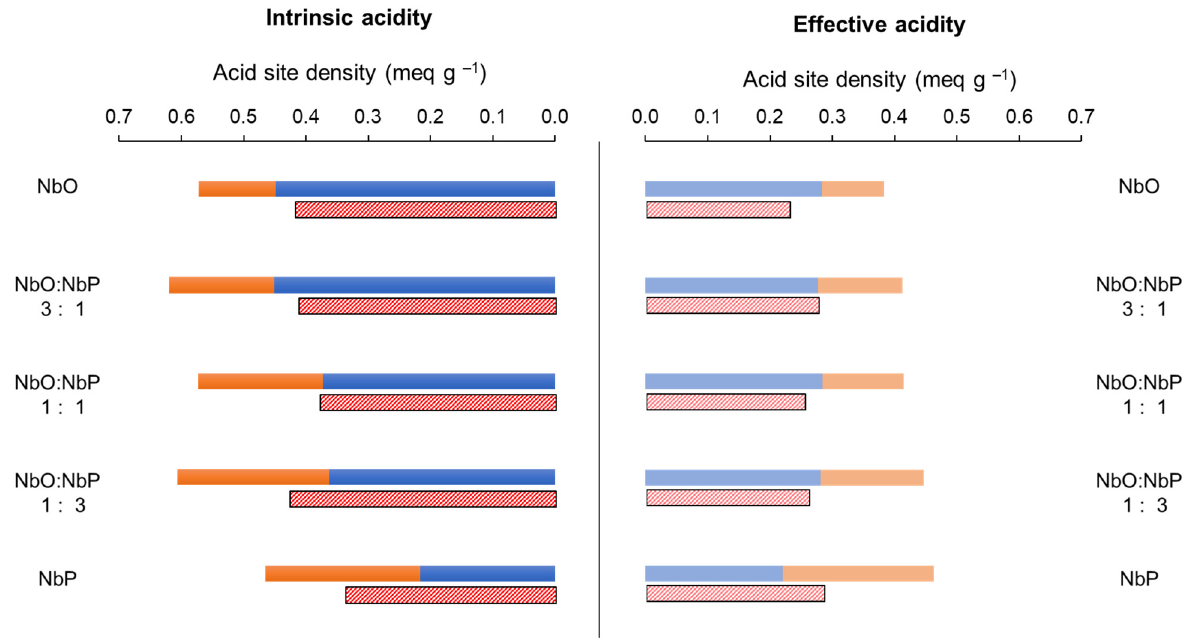
Figure 7. Surface acid site density of the studied samples: LAS and BAS determined by combining results from solid-liquid phase titrations with PEA (see Table S2) and FT-IR adsorption with pyridine (PY) (from desorption at 150 °C). Solvent, cyclohexane for intrinsic acidity, and water/isopropanol mixture for effective acidity measurements.